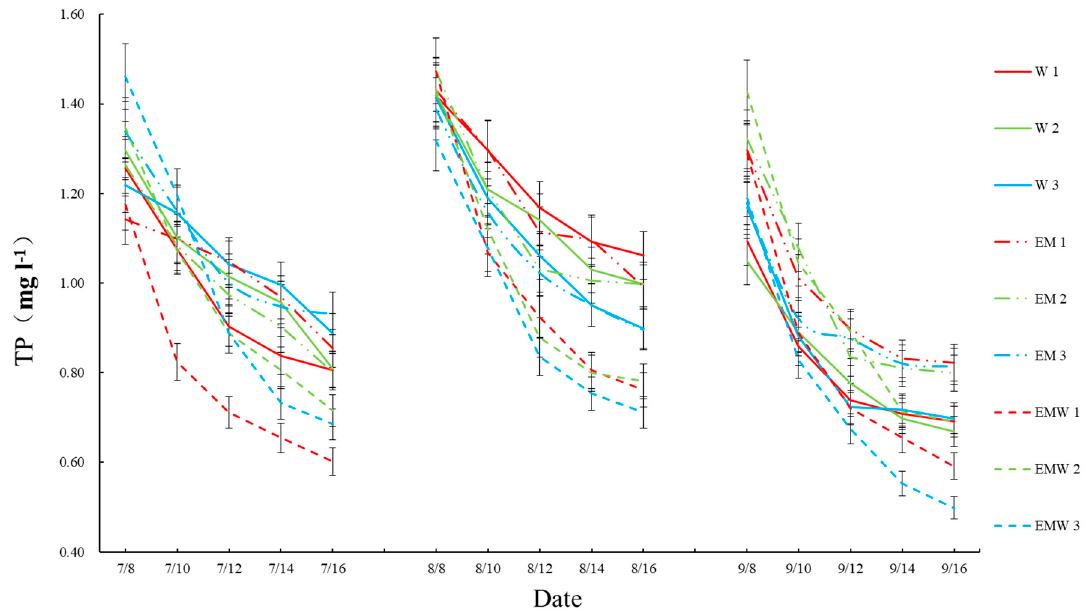
Figure 5. Total phosphorus (TP) concentration changes with time in wetlands.